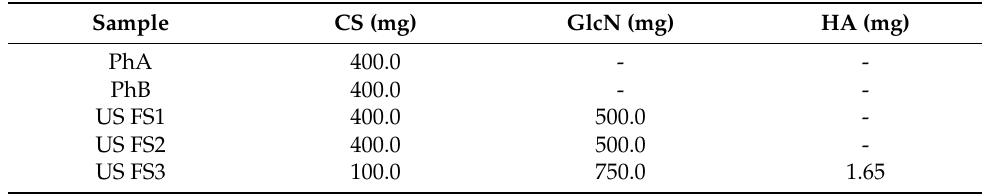
Table 1. The CS, GlcN and HA contents per dose of the two pharmaceuticals and of the three USA food supplements, as declared on their